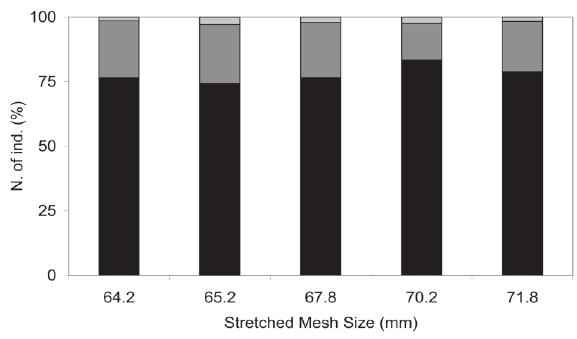
Fig. 4. – Percentage of soles caught with gill nets subdivided ac- cording to the method of capture. Black = mouth clapped; dark grey = gilled; light grey = wedged.